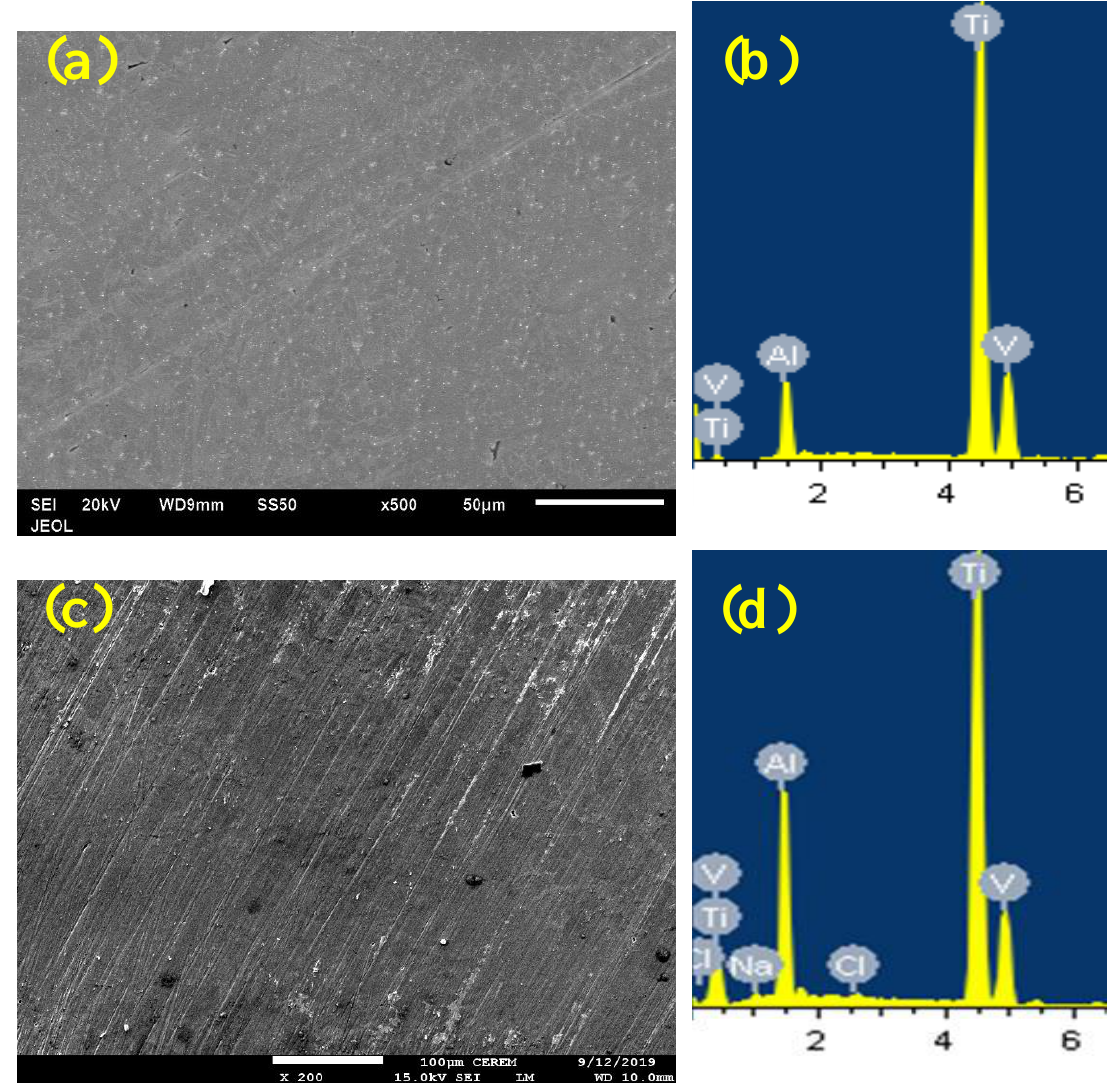
Figure 13. ( a ) SEM and ( b ) EDX analysis for the surface of sintered Ti-6%Al-4%V alloy before its immersion; ( c ) SEM and ( d ) EDX analysis for the surface of the corroded Ti-6%Al-4%V alloy that was immersed in 3.5% NaCl solution for 48 h before stepping the potential at 300 mV for 30 min.